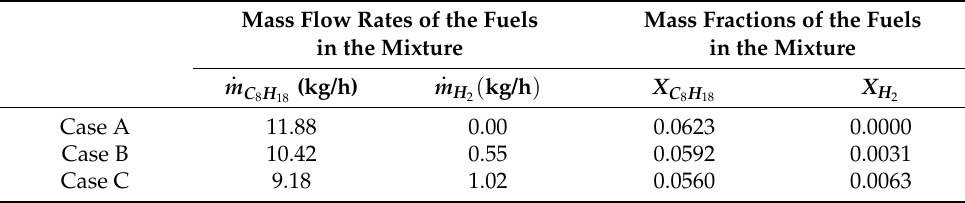
Table 3. Mass flow rates and mass fractions of the fuel